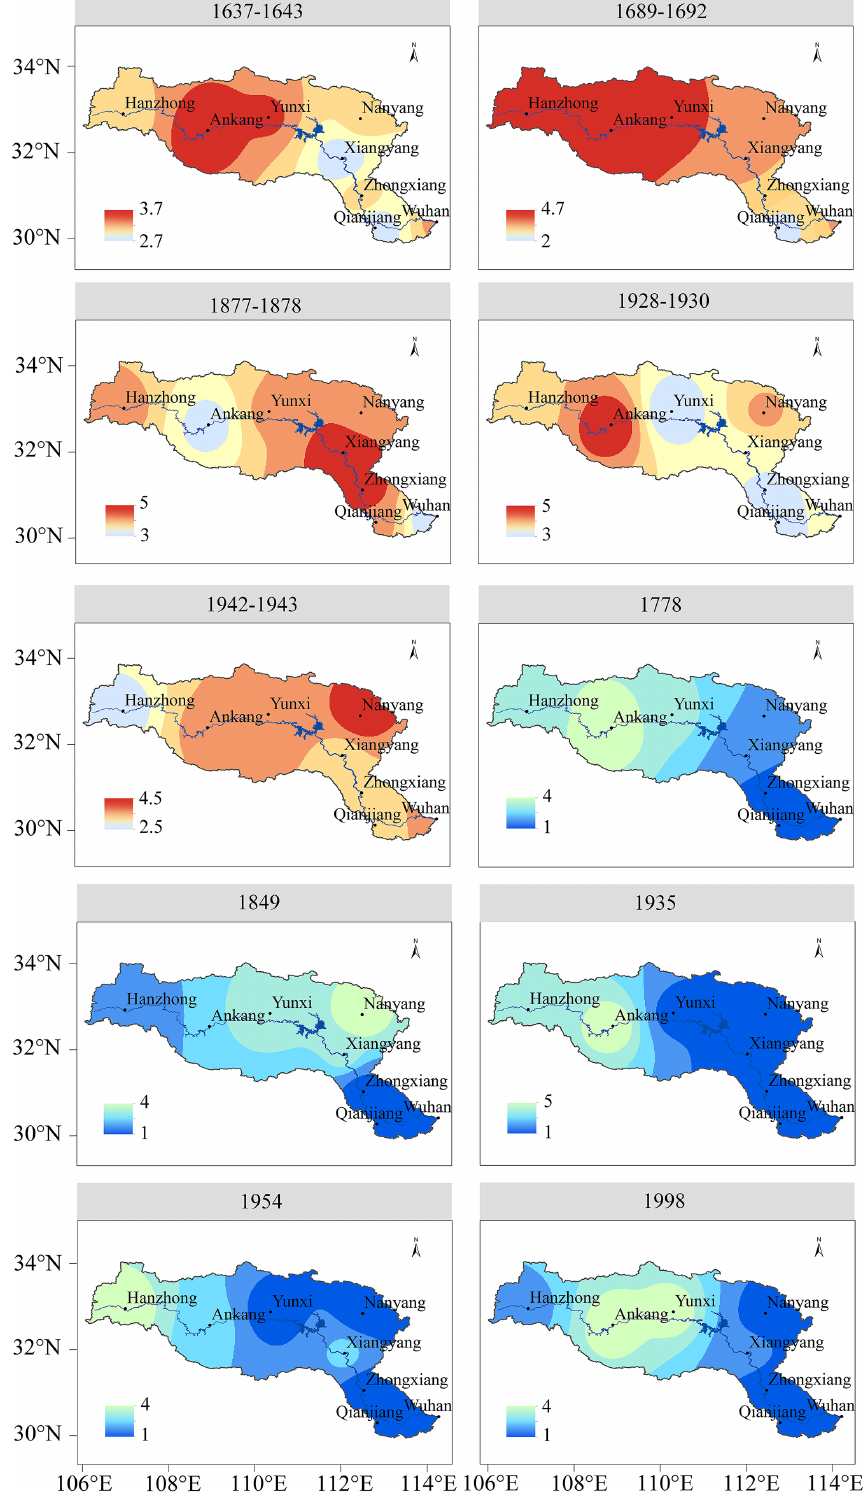
Figure 8. The spatial distribution of average drought and flood grades in the HRB during severe droughts in North China (1637–1643, 1689–1692, 1877–1878, 1928–1930, and 1942–1943) and severe floods in the Yangtze River Basin (1788, 1849, 1935, 1954, and 1998). The color bar indicates the grade of drought and